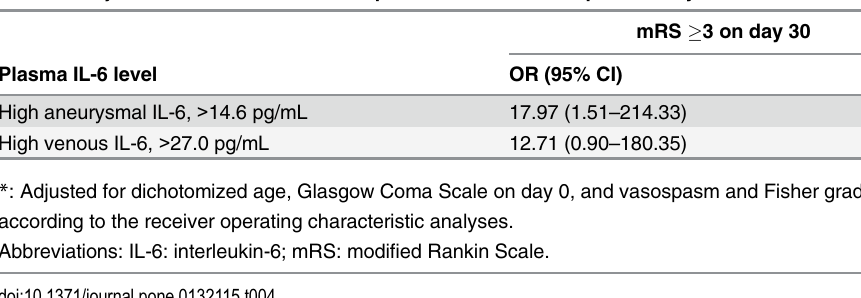
Table 4. Adjusted associations between plasma IL-6 levels and poor 30-day